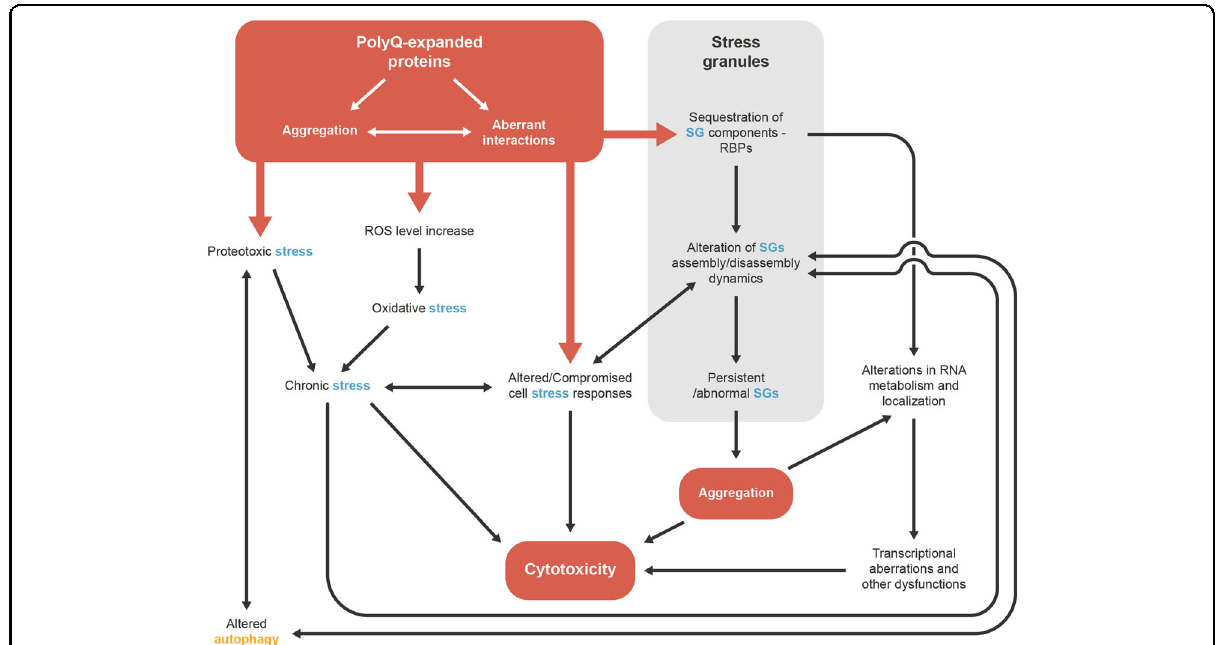
Fig. 4 The putative involvement of stress granules in the molecular pathophysiology of polyglutamine diseases. Proteins bearing an expanded polyglutamine (PolyQ) tract display a tendency to aggregate and to engage in aberrant intermolecular interactions. Association of PolyQ- expanded proteins with stress granules (SGs) components, in particular RNA-binding proteins (RBPs) that are often prone to aggregate, may alter the dynamics of SGs assembly and disassembly. This can compromise SGs functionality, contributing to the globally de fi cient cell stress response that has been described to be a component of the molecular pathophysiology of PolyQ diseases. Oxidative stress (associated with an increase in reactive oxidative species - ROS - levels) and proteotoxic stress, which are known to result from expanded PolyQ protein expression, may culminate in a state of chronic cell stress, which may add to the abnormal SG assembly/disassembly dynamics and lead to the persistence of SGs. SGs formed under chronic stress are known to acquire abnormal properties and to seed toxic aggregation. Defects in autophagy caused by PolyQ protein expression may also contribute to the persistence of SGs and to their altered dynamics. Additionally, both the sequestration of RBPs to PolyQ aggregates and the toxic aggregation triggered by SGs may alter RNA metabolism and its subcellular localization, which in turn may lead to transcriptional aberrations. Chronic stress, a reduced ability to cope with cell stress, transcriptional alterations and a pernicious cascade of protein aggregation involving both the PolyQ-expanded proteins and the SGs may combine to produce the cytotoxic pro fi le with is at the basis of cell dysfunction and loss, in PolyQ